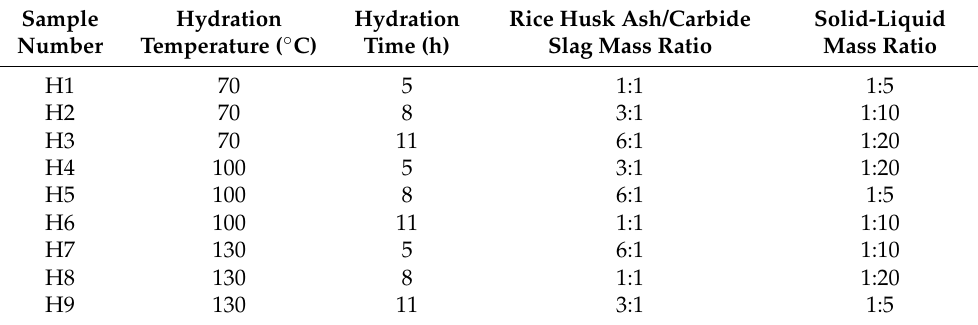
Table 2. Orthogonal experimental design table for preparation conditions of